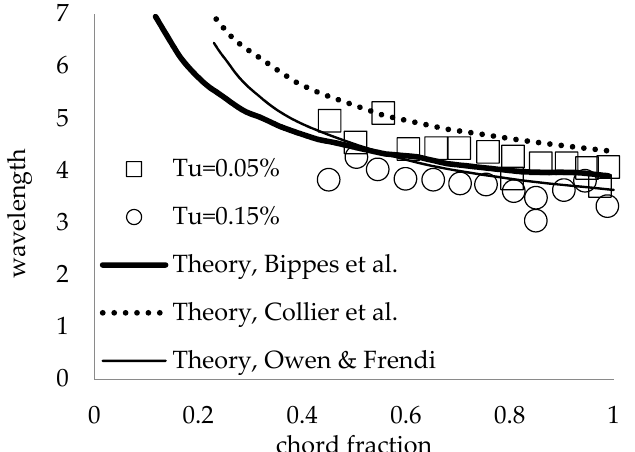
Figure 7. Plot of the most amplified stationary wavelength parallel to the plate LE as a function of the chord fraction. Measurements shown for two different wind tunnel turbulence intensities, Tu.